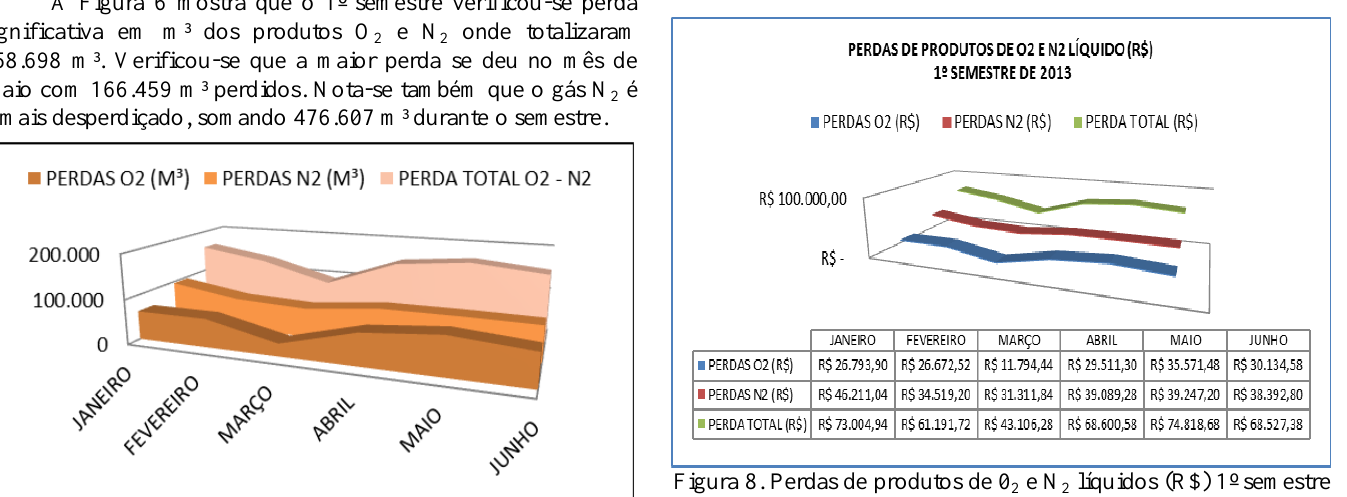
e N líquidos m 3 – 1º Semestre de 2 2